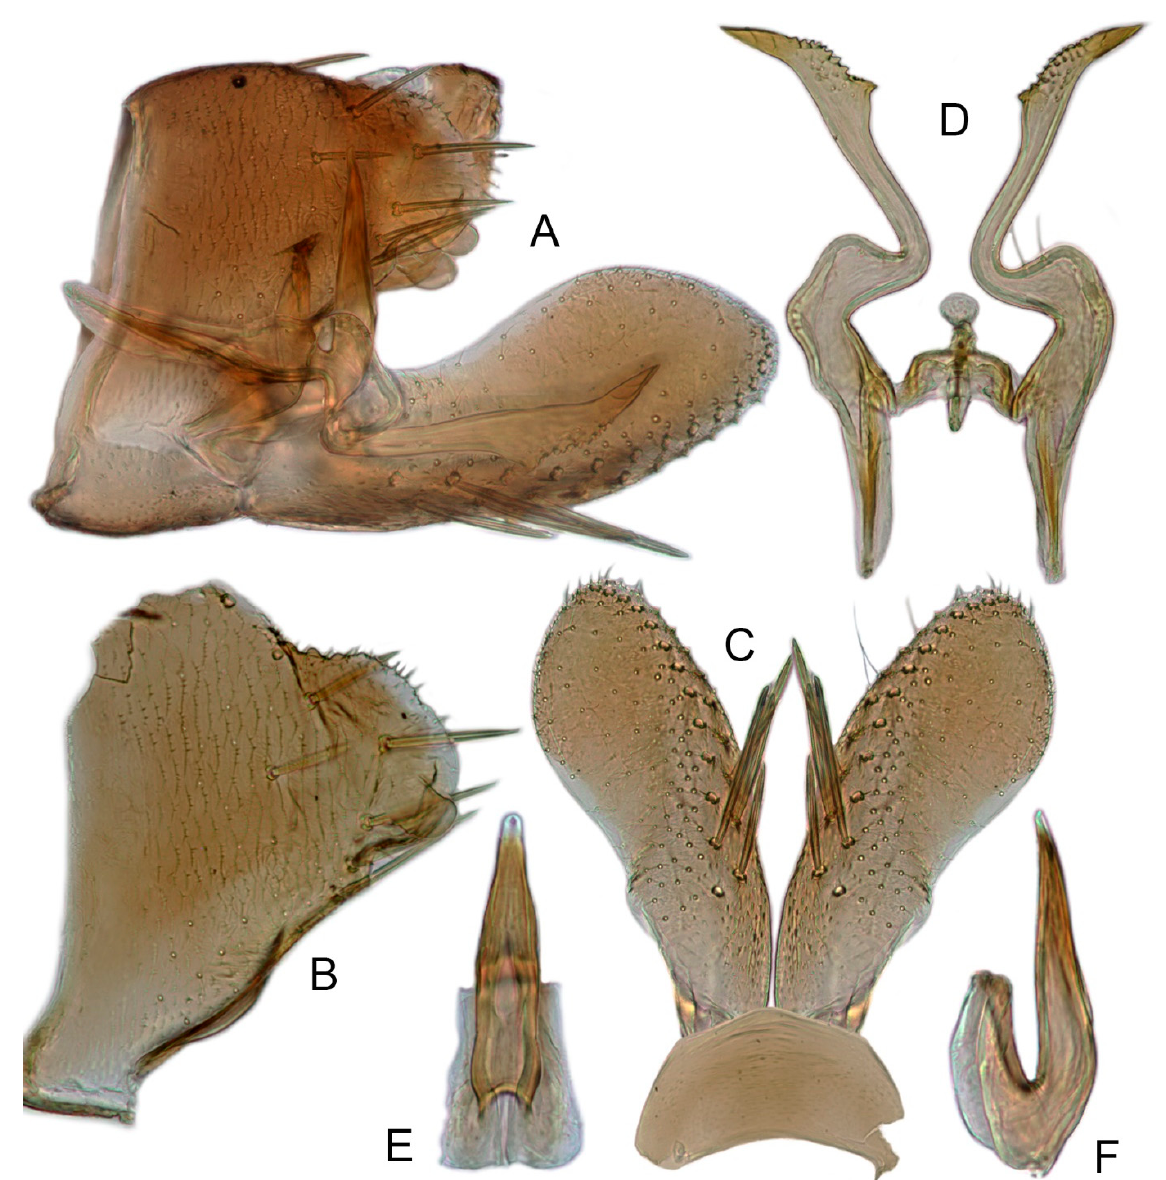
Figure 6. Xestocephalus gracilus sp. nov. ( A ) Male genital capsule, lateral view; ( B ) pygofer lobe, lateral view; ( C ) subgenital plates and valve, ventral view; ( D ) style and connective, ventral view; ( E ) aedeagus, posterior view; ( F ) aedeagus, lateral view.